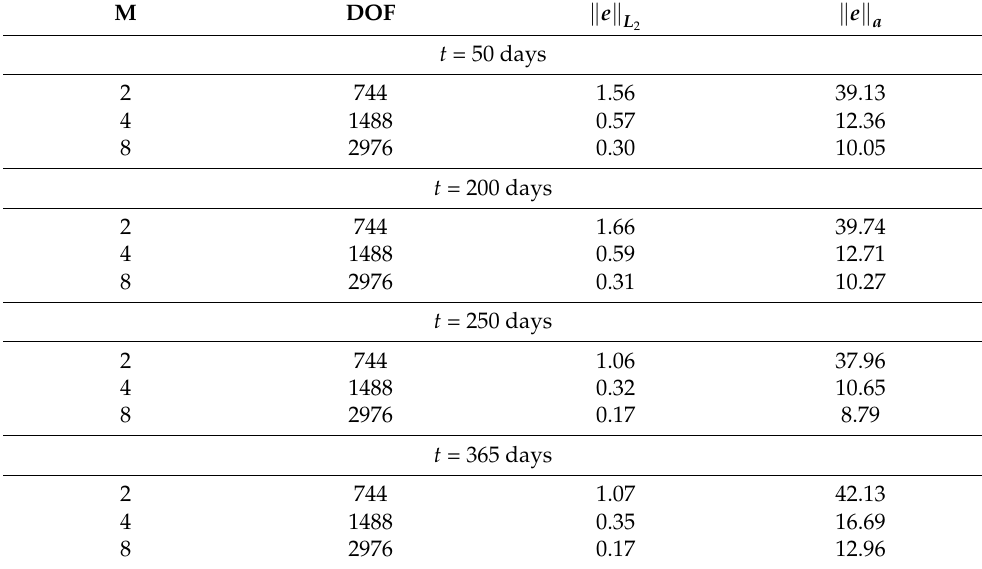
Table 5. Relative L 2 and energy errors (%) for different number of multiscale basis functions (DOF f = 207,599). Case 3: random distribution of basalt fibers.